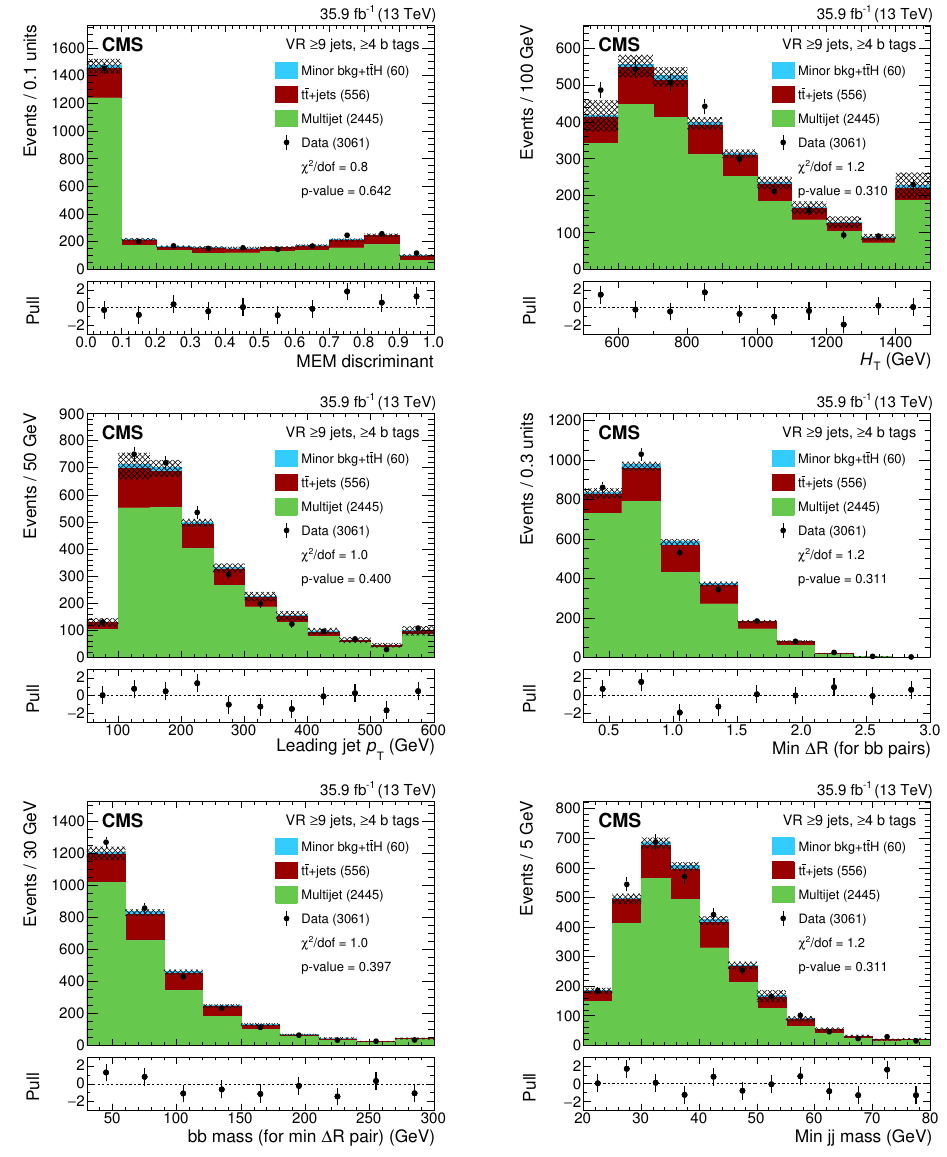
Figure 4 . Distributions in data, in simulated backgrounds, and in the estimated multijet back- ground for the ( 9j, 4b) VR category. The MEM discriminant (upper left), H T (upper right), (cid:21) (cid:21) p T of the leading jet (middle left), minimum (cid:1) R between b jets (middle right), invariant mass of the closest b jet pair (lower left), and minimum mass of all jet pairs (lower right). The level of agreement between data and estimation is expressed in terms of a (cid:31) 2 divided by the number of degrees of freedom (dof), which are given along with their corresponding statistical p -values. The di(cid:11)erences between data and the total estimates divided by the quadratic sum of the statistical and systematic uncertainties in the data and in the estimates (pulls) are given below the main panels. The numbers in parenthesis in the legends represent the total yields for the corresponding entries. The last bin includes event